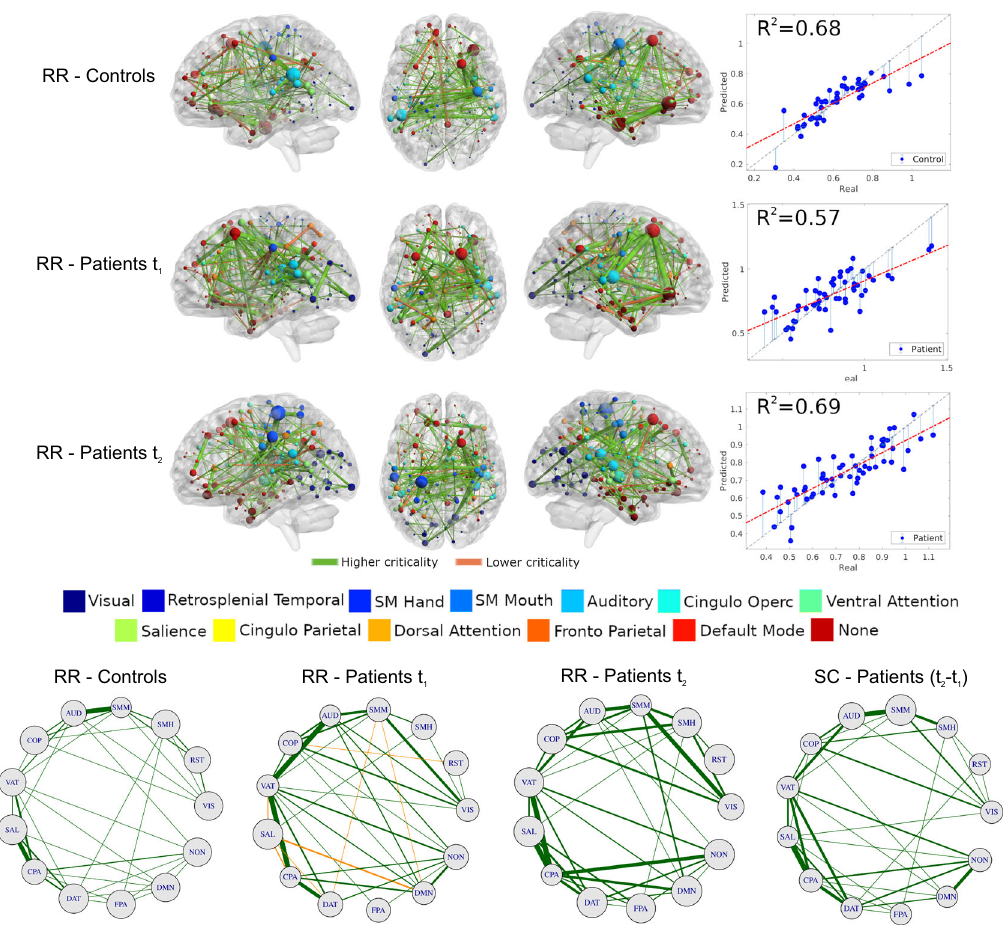
Fig. 5 Structural connectivity related to criticality (integral of the second cluster size I 2 = ∫ S 2 dT ). Top: map of predictive connections of W (see Eq. (14)). Structural edges that predict higher (green edges) and lower criticality (orange edges) values (top: controls; middle: patients at t 1 ; bottom: patients at t 2 ). Only the highest 200 connections are shown for ease interpretation. The size of each ROI, colored by network, corresponds to the number of predictive edges converging on it. The scatter plot shows real vs. predicted criticality values from the Ridge Regression model. The gray dashed line has a slope of one and is a guide to the eye. Circle plots: architecture of averaged network connections across resting-state networks ( 〈 W 〉 X , Y , see main text). The fi rst three plots, from left to right, represents the ridge regression maps (Eq. (14)), while the last map represents the difference of the patients' structural connectivity matrix at t 2 − t 1 . The size of each RSNs corresponds to the average connections within networks. Source data are provided as a Source Data fi